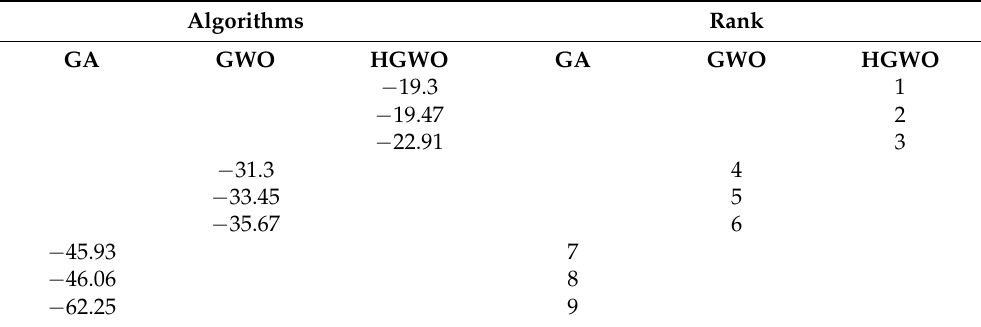
Table 3. Non-parametric statistical analysis of the GA, GWO and HGWO performances for path planning of multiple